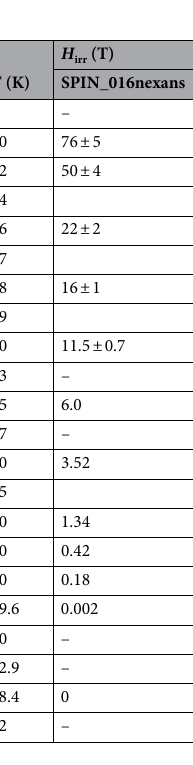
Table 1. Irreversibility field, H irr , values of the two investigated Bi-2212 wires SPIN_016nexans and SPIN_036engimat. High temperature values are obtained by isothermal M - H hysteresis loops, whereas